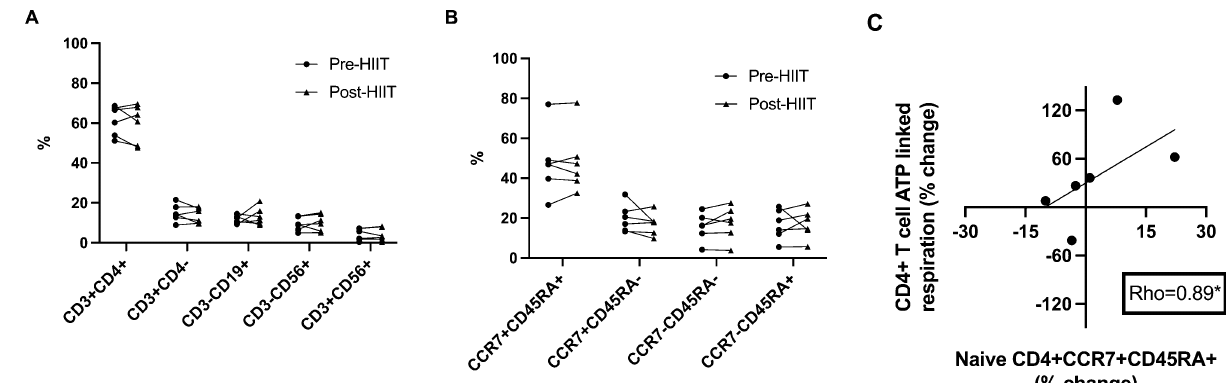
Figure 2. Changes in RA T cell oxidative metabolism following HIIT are associated with changes in naïve T cells. ( A ) Graphs show changes in rheumatoid arthritis (RA) peripheral CD3 + CD4 + helper T cells, CD3 + CD4- non-helper T cells, CD3-CD19 + B cells, CD3-CD56 + natural killer cells, and CD3 + CD56 + natural killer T cells following high-intensity interval training (HIIT) (subgroup n = 6; p > 0.05 for all pre-HIIT versus post- HIIT comparisons). ( B ) Graphs show changes in RA peripheral naïve CCR7 + CD45RA + , central memory CCR7 + CD45RA-, effector memory CCR7-CD45RA-, and terminally differentiated CCR7-CD45RA + CD4 + T cells following HIIT (p > 0.05 for all pre-HIIT versus post-HIIT comparisons). ( C ) Scatter plot depicts relationship between percent change in RA peripheral CD4 + T cell ATP linked respiration (y-axis) and